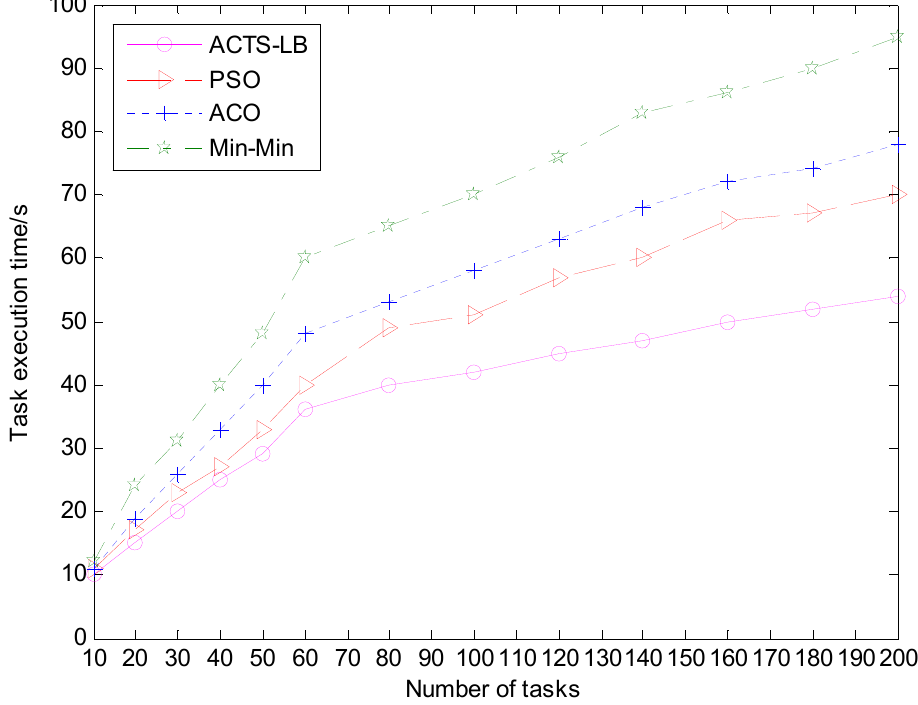
Figure 7. The comparison of task execution time span under different scheduling tasks.